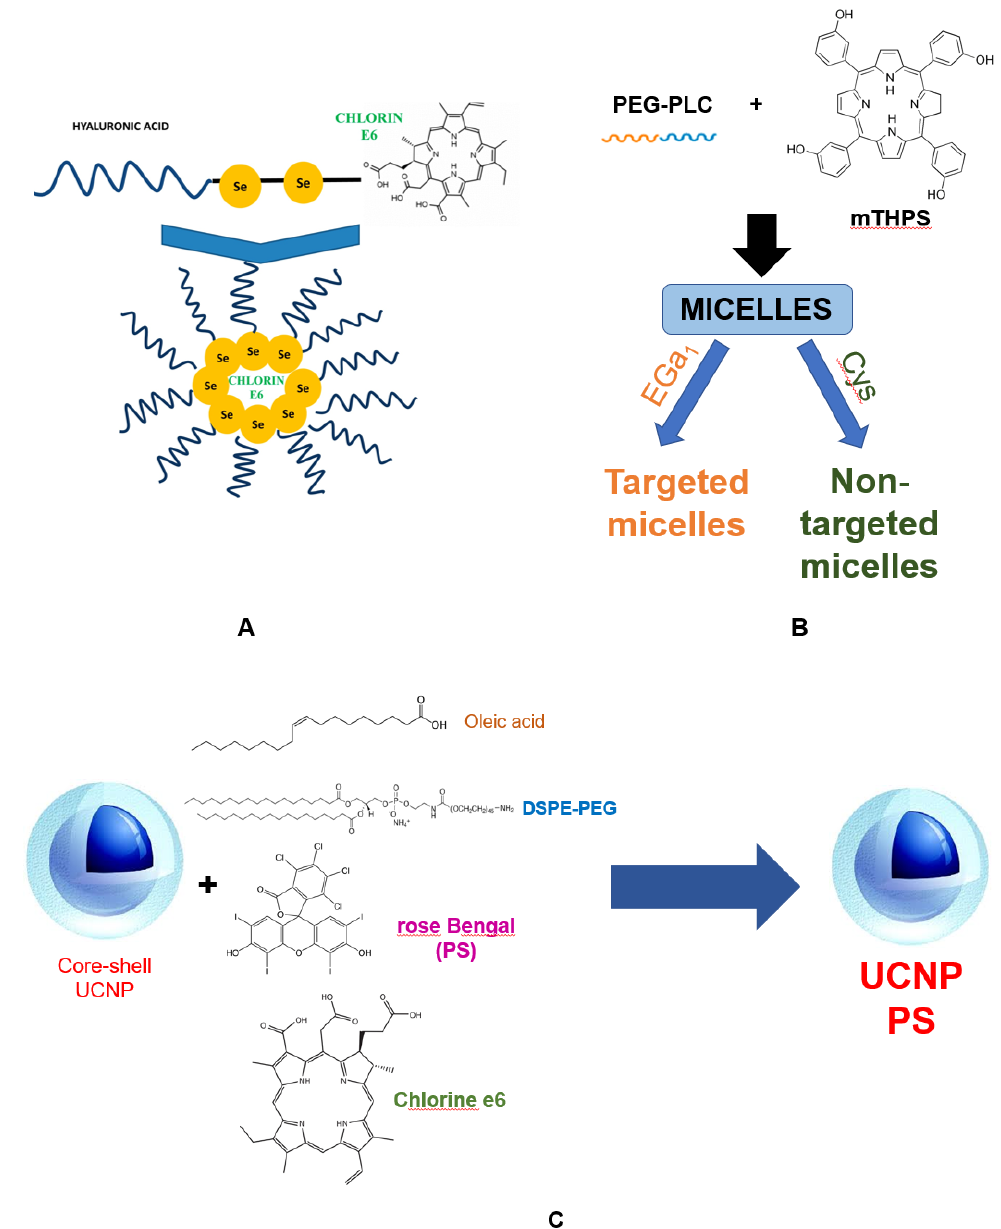
Figure 3. General schemes for the synthesis of PS nanoparticles: ( A )—Scheme of self-assembling HA-sese-Ce6 micelles, redox sensitive Ce6 release, and positive feedback loop that triggers more Chlorin e6 release; ( B )—Scheme of upconversion nanoparticles a core-shell structure contain PS Chlorin e6 and Rose Bengal UCNPs; ( C )—Scheme of з reparation of polymeric micelles conjugated with EGa1 (Targeted) or Cys